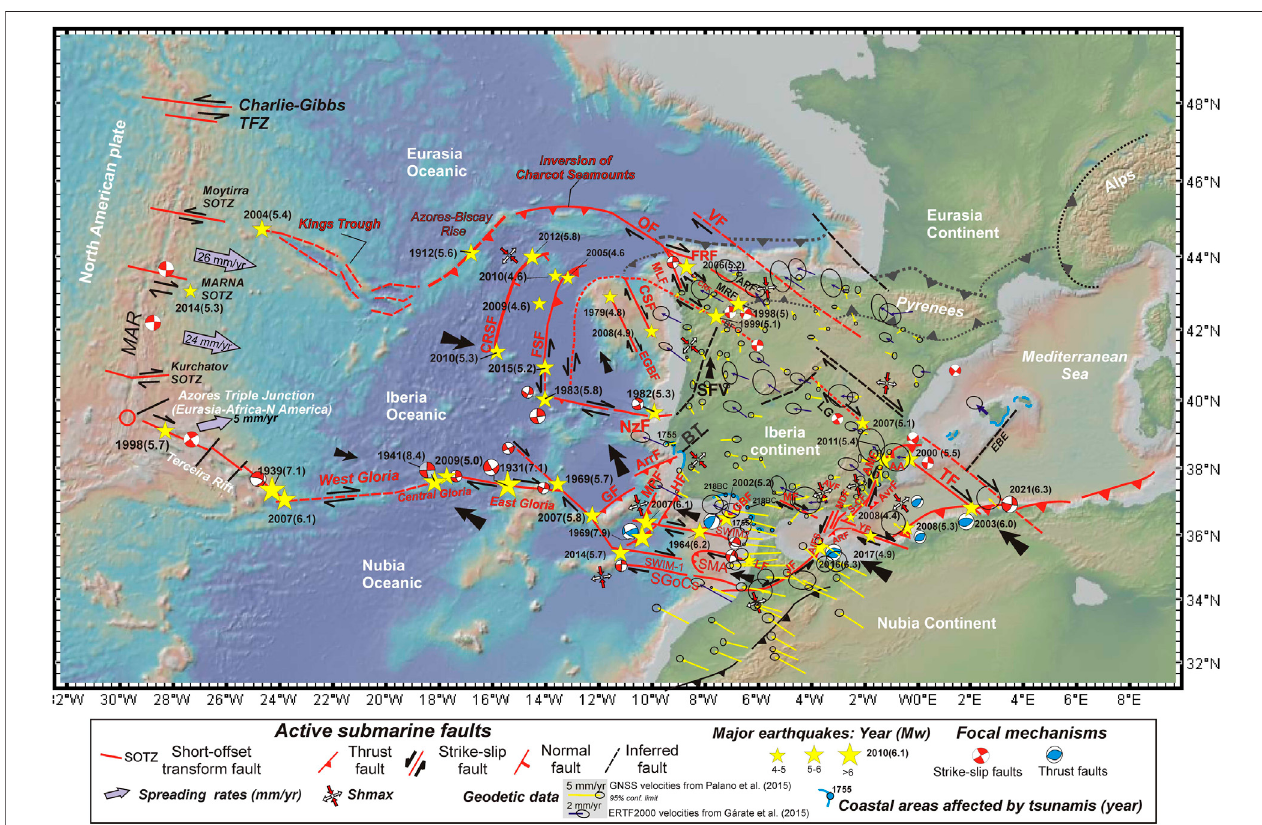
FIGURE 14 | Synthesis map of the main active submarine faults around Iberia with location of the main Mw > 5 earthquakes (yellow stars). Active submarine faults by regions; (A) GulfofCádiz.ArrF: ArrabidaFault; GBF: Gualdalquivir Bank Fault; GF: GorringeFault; HF:HorseshoeFault; LF: Larache Fault; MPF:Marques de Pombal Fault; SGoCs: South GulfofCadizShearZone;SMA:South MoroccanArc. (B) Alborán Sea.AIFS: AlIdrisiFault System; ARF: Alborán RidgeFault; AVF:Averroes Fault; JF: El Jebha Fault; MF: Maro-Nerja Fault; MDF: Motril-Djibouti Fault System; S-CF: La Serrata Carboneras Fault; YF: Yusuf Fault. (C) SE and E Iberia. AA: Aguilas Arc; AMF:Alhamade MurciaFault; AvrF: AbubacervolcanicridgeFault; TF: TorreviejaFault; EME:EmileBaudot Escarpment. (D) Nand NWIberia Margin. CRF: Coruña Fault; CSF: Castelao Fault; CRSF: Coruña Seamount Fault; EGBF: East Galicia Bank Fault; FRF: Ferrol Fault; FSF: Finisterre Seamount Fault; MLF: Malpica Fault; OF: Ortegal Fault; VF: Ventaniella Fault. (E) Iberia intraplate active fault lineations (from Vegas et al., 2008). BT (cid:2) Bajo Tagus; SFV (cid:2) Vilarica Fault System; LG: Guadiana Lineaments. (F) Onshorefaults.APF:AsPontesFault;BF:BecerreáFault;MRF:Meirama.GeodeticGPSvelocitiesand95percentcon fi denceellipsesdatafromGárate etal.(2015)andPalanoetal.(2015).S hmax directionsfromAndewegetal.(1999),Fernández-Ibáñezetal.(2007)andPedreraetal.(2011).Earthquakedistributiontaken from the Instituto Geográ fi co Nacional (www.ign.es) and SHARE database (Giardini et al., 2013). Tsunamis from Lario et al. (2011). Background bathymetry from Ryan et al. (2009). Abbreviations are also listed in the Supplementary Table S2